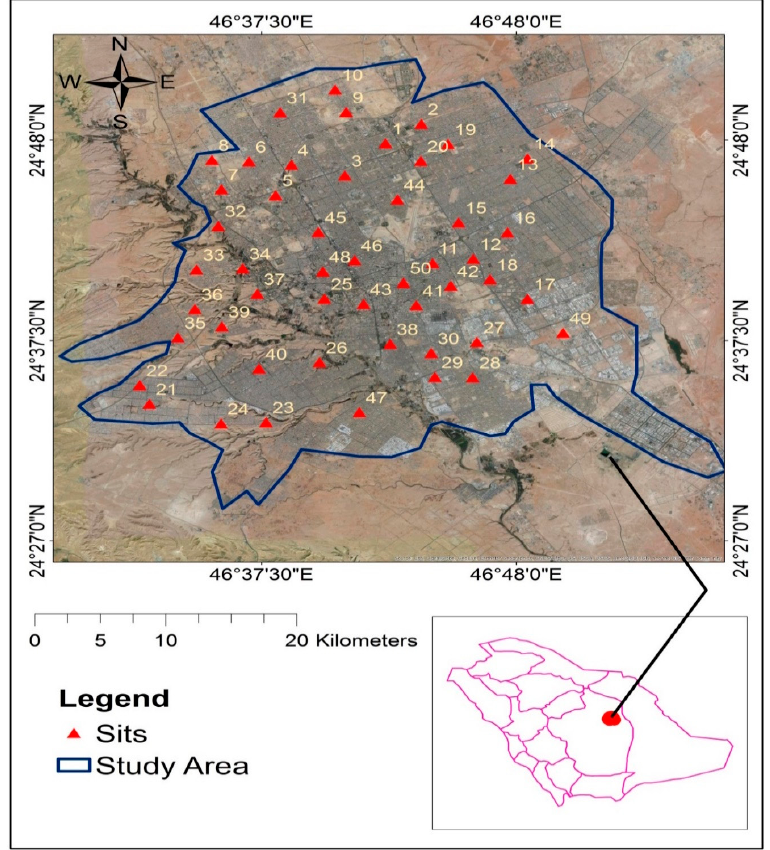
Figure 1. Sampling locations of air dust samples in Riyadh City, Saudi Arabia.